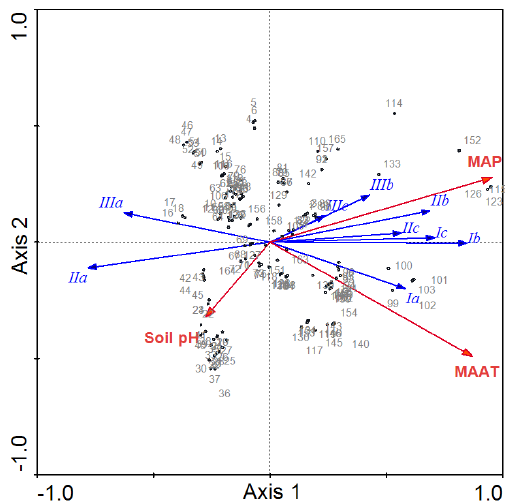
Figure 3. RDA triplot showing the relationships between environ- mental variables (red arrows) and fractional abundances of the nine bGDGTs (blue arrows) for the 165 Chinese alkaline soil samples compiled in Yang et al. (2014a) and in this study. Numbers refer to samples listed in Supplementary Table